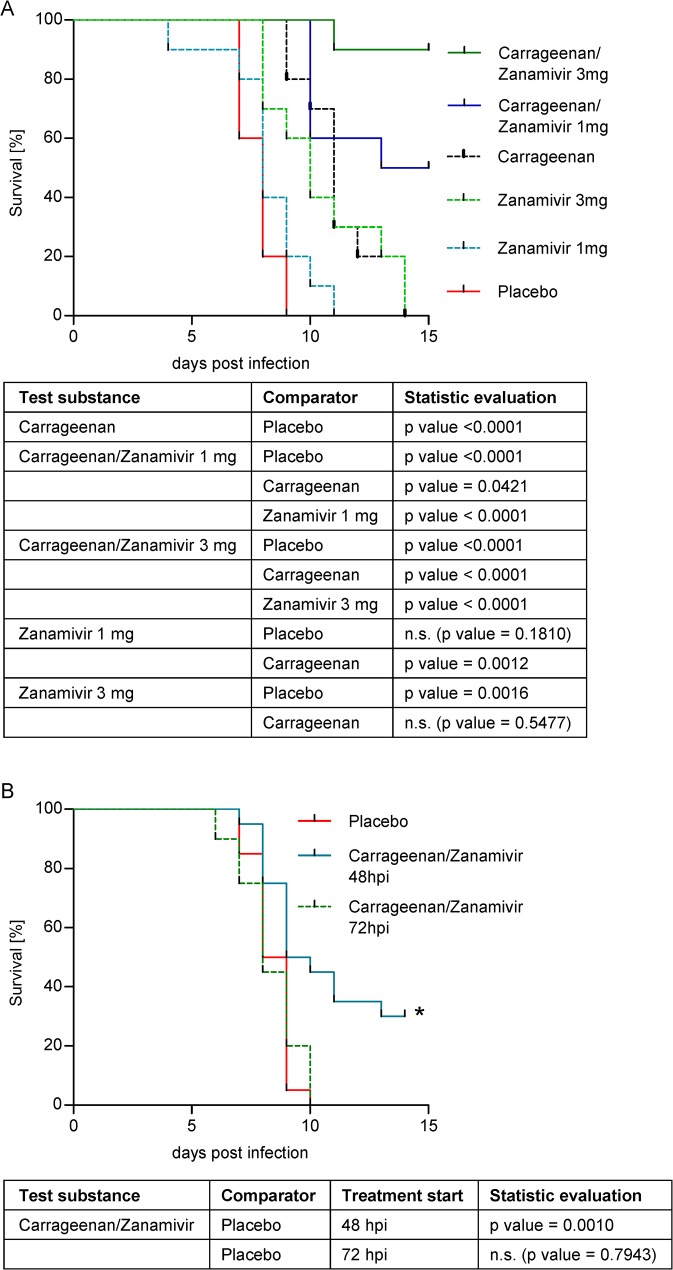
Therapeutic efficacy in influenza H7N7 lethally infected mice.(A) Mice (n = 10 per group) were lethally intranasally infected without anesthesia on day 0 and intranasally treated twice per day either with placebo or with the mono-therapies consisting of carrageenan (12 mg/kg BW/day) or Zanamivir (1 and 3 mg/kg BW/day) or a combination thereof. Treatment started 24 hpi and continued for 5 days. (B) Mice (n = 20 per group) were lethally intranasally infected without anesthesia on day 0 and intranasally treated twice per day either with placebo or a combination of carrageenan with Zanamivir (3 mg/kg BW/day). Treatment started either 48 hpi or 72 hpi and continued for 5 days. On the y-axis the survival of mice [%] and on the x-axis the time post infection [days] is given. Placebo treated uninfected control mice showed 100% survival in both experiments (data not shown). Statistical analyses were conducted using log rank test and are shown beneath the graphs. Values of p<0.05 were considered statistically significant; non-significance (n.s.) was obtained with p-values >0.05.